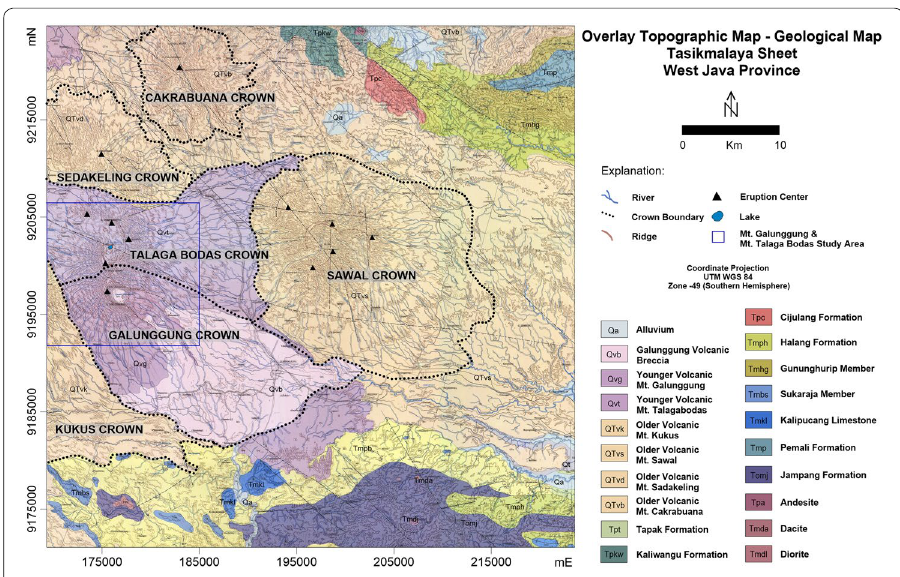
Fig. 2 Geological map Karaha–Talaga Bodas area (Budhitrisna